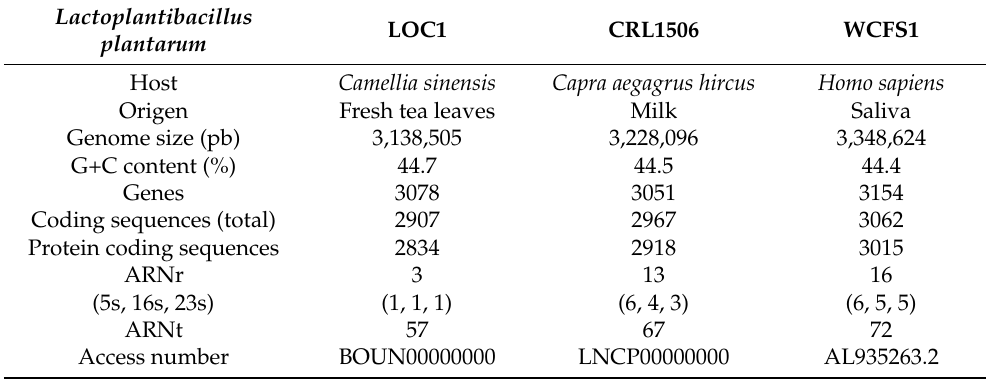
Table 1. General genomic characteristics of the L. plantarum LOC1. The genome of the LOC1 strain was studied and compared with the probiotic strains WCFS1 and CRL1506 as